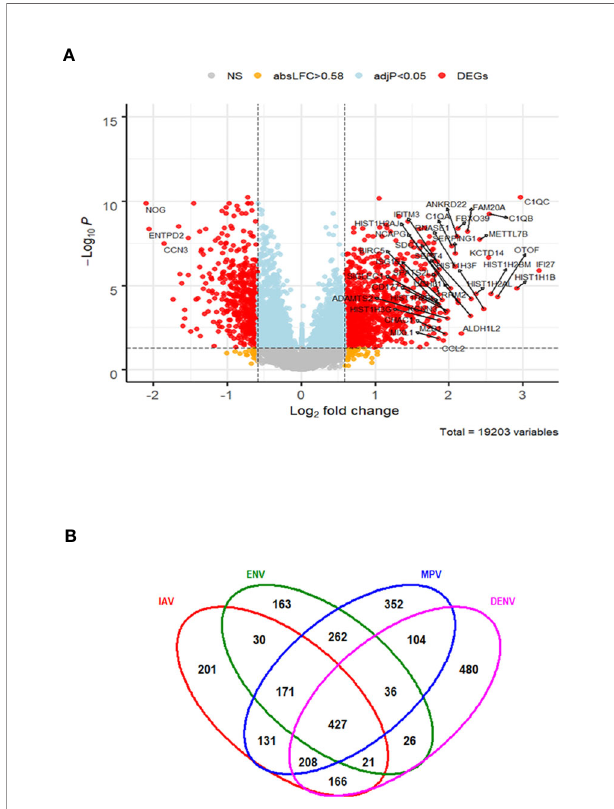
FIGURE 6 | Host response in DENV infections. (A) Volcano plot of results of the contrast from the linear regression analysis of DENV infected versus healthy controls. y-axis: -log 10 BH multiple testing adjusted p-values, x-axis: log 2 fold change. DEGs (absolute log-fold change > 1.5, corresponding to a log 2 -fold change > 0.58; multiple testing adjusted p-value < 0.05) are colored red and the top 40 most strongly regulated (by log-fold change) DEGs are labeled. Blue: genes with adjusted p-value < 0.05. (B) Venn diagram of verlap of DEGs from single contrasts of respiratory and DENV infections to healthy controls. A total of 2778 DEGs were identi fi ed in all infections, 427 DEGs were commonly shared between all infections. 480 DEGs were only regulated in DENV infections. IAV: DEGs from in fl uenza versus healthy controls, ENV: DEGs from entero/rhinovirus versus healthy controls, MPV: DEGs from metapneumovirus versus healthy controls, DENV: DEGs from dengue virus versus healthy controls. NS, not signi fi